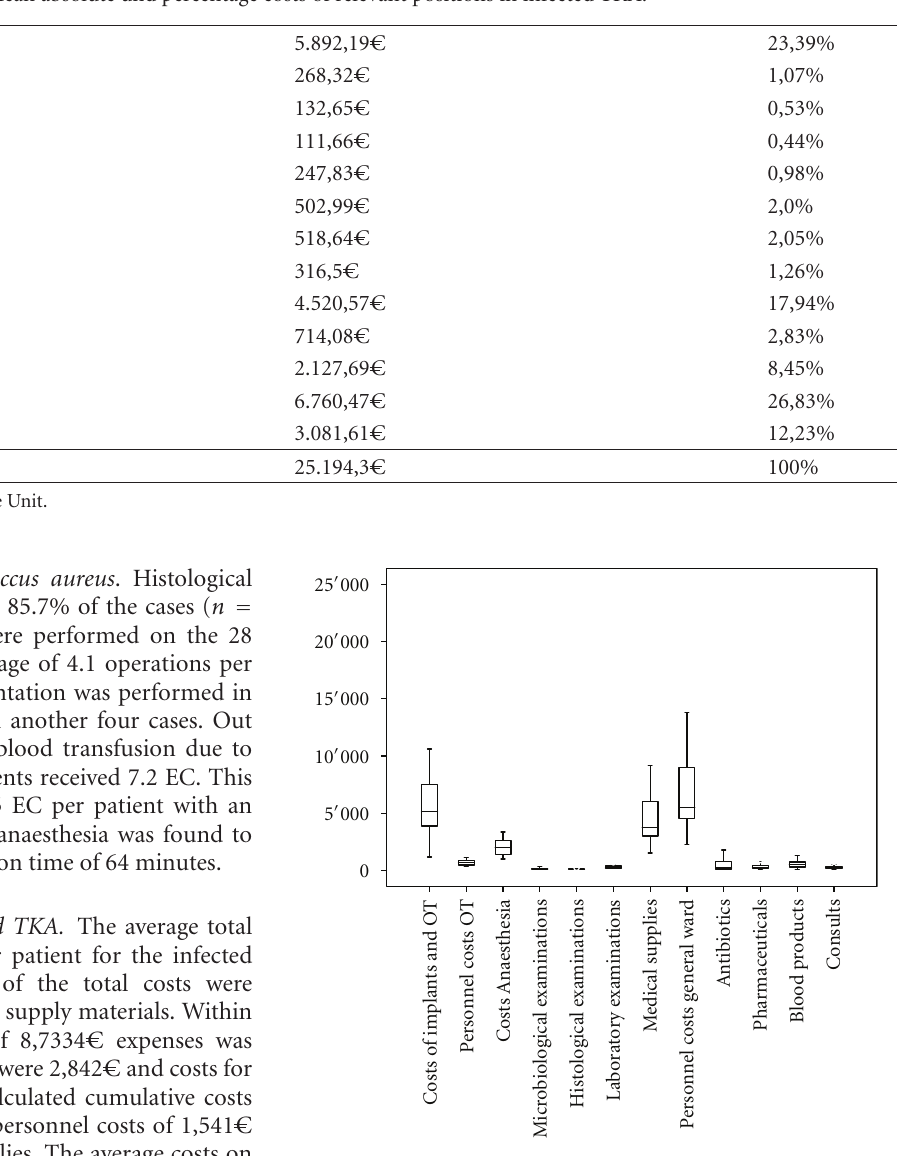
Figure 1: Mean, standard deviation, minimum, and maximum values of the various positions for infected TKA in